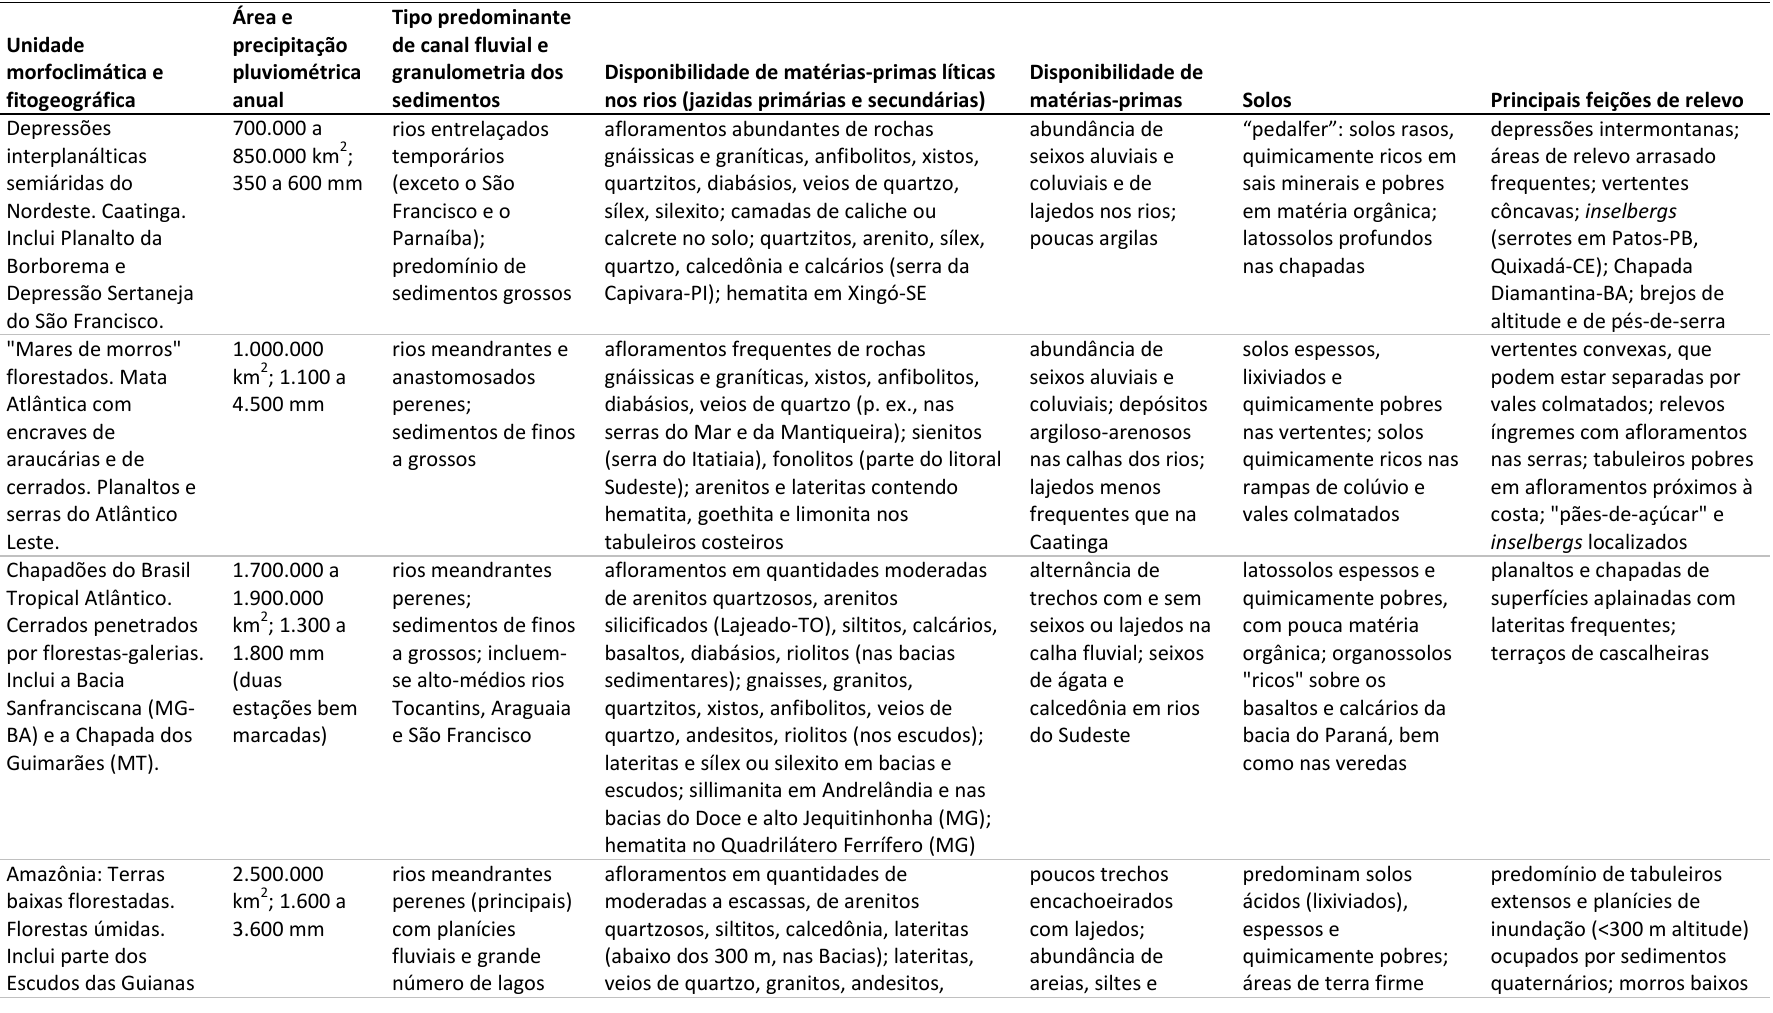
Table 2. Main Brazilian landscapes realms and simplified synthesis of the regional availability of lithic raw-materials in rivers and watersheds. Main sources: Ab’Sáber (1967, 1971, 2005), Santos et al. (1982), Ross (1991), Suguio (2005), Latrubesse et al. (2005) e Lima da Costa et al.